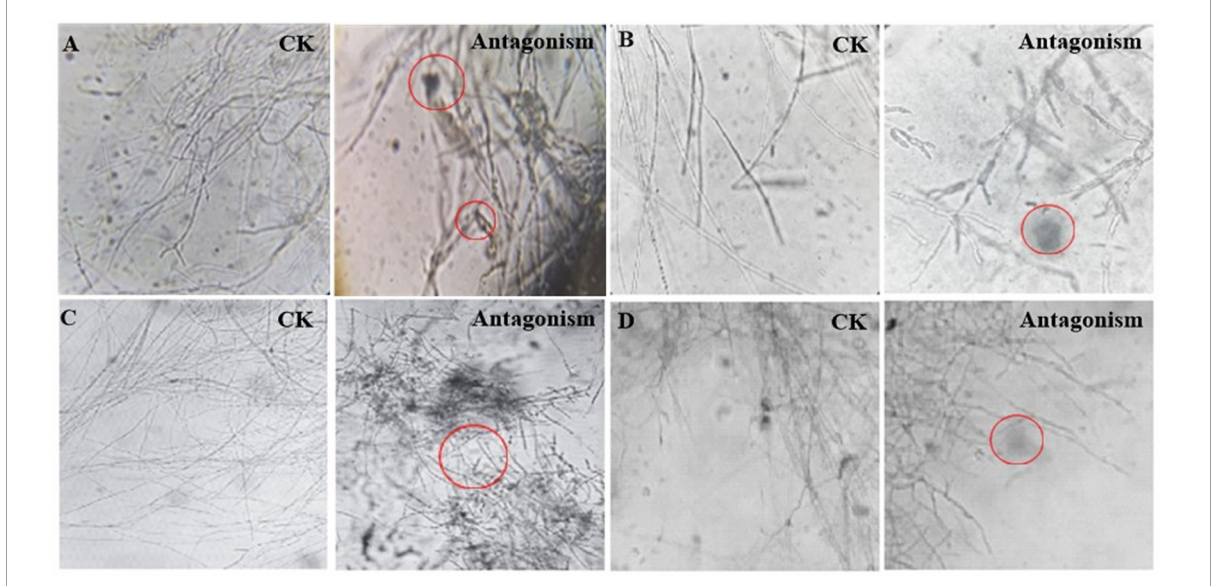
FIGURE2 Microscopic morphology of Streptomyces MDJK11 and MDJK44 co-culture antagonistic indicator strains (A) , Fusarium oxysporum , (B) , Fusarium solani , (C) , Fusarium moniliforme , (D) , Fusarium graminearum , the red circles represent the abnormal phenomenon of the indicator